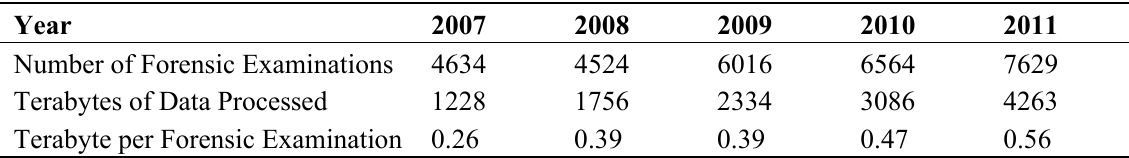
Table 1. The number of forensic examinations and amount of data processed by the FBI from 2007 to 2011 [3–7].